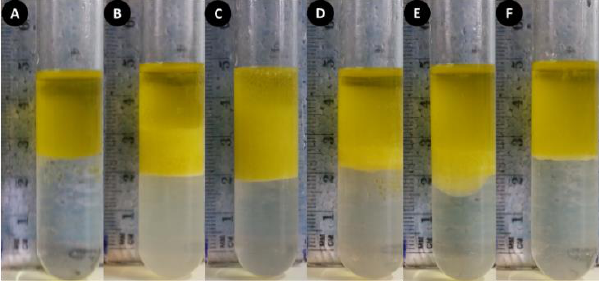
Figure 1. Emulsification assays (E 24 test) resulting from the mixture of olive oil and supernatants from cultures of G. alkanivorans strain 1B cultivated using different carbon and sulfur sources: ( B ) Olive oil and Na 2 SO 4 ; ( C ) Fructose and DBT; ( D ) Fructose and Na 2 SO 4 ; ( E ) Glucose and DBT; and ( F ) Glucose and Na 2 SO 4 . ( A ) Negative control with water and olive oil.